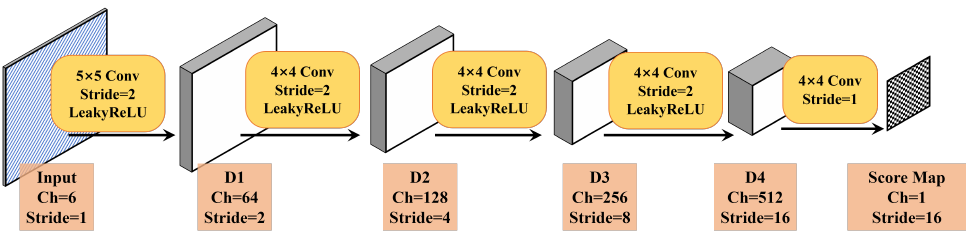
Figure 5. Network structure of the track